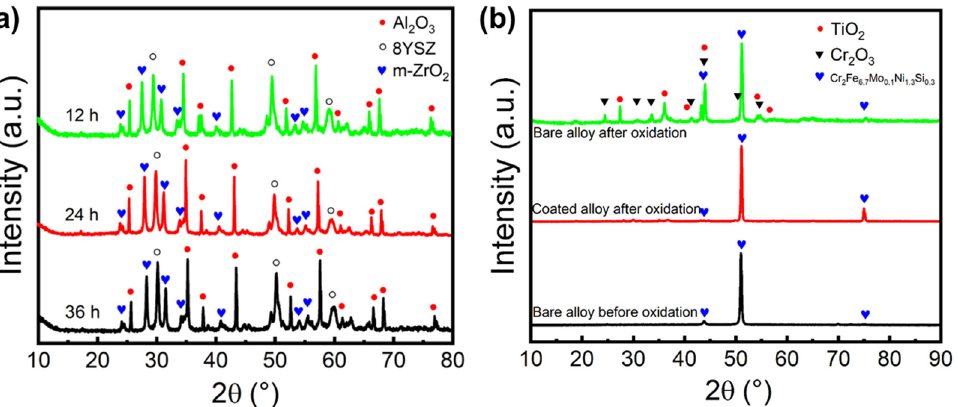
Figure 9. XRD patterns of ( a ) the SiOC/Al 2 O 3 /YSZ coatings after oxidation test at 1000 °C for 12 h, 24 h, and 36 h, and ( b ) the K3 alloy substrate with and without the coating after oxidation test at 1000 °C for 36 h.